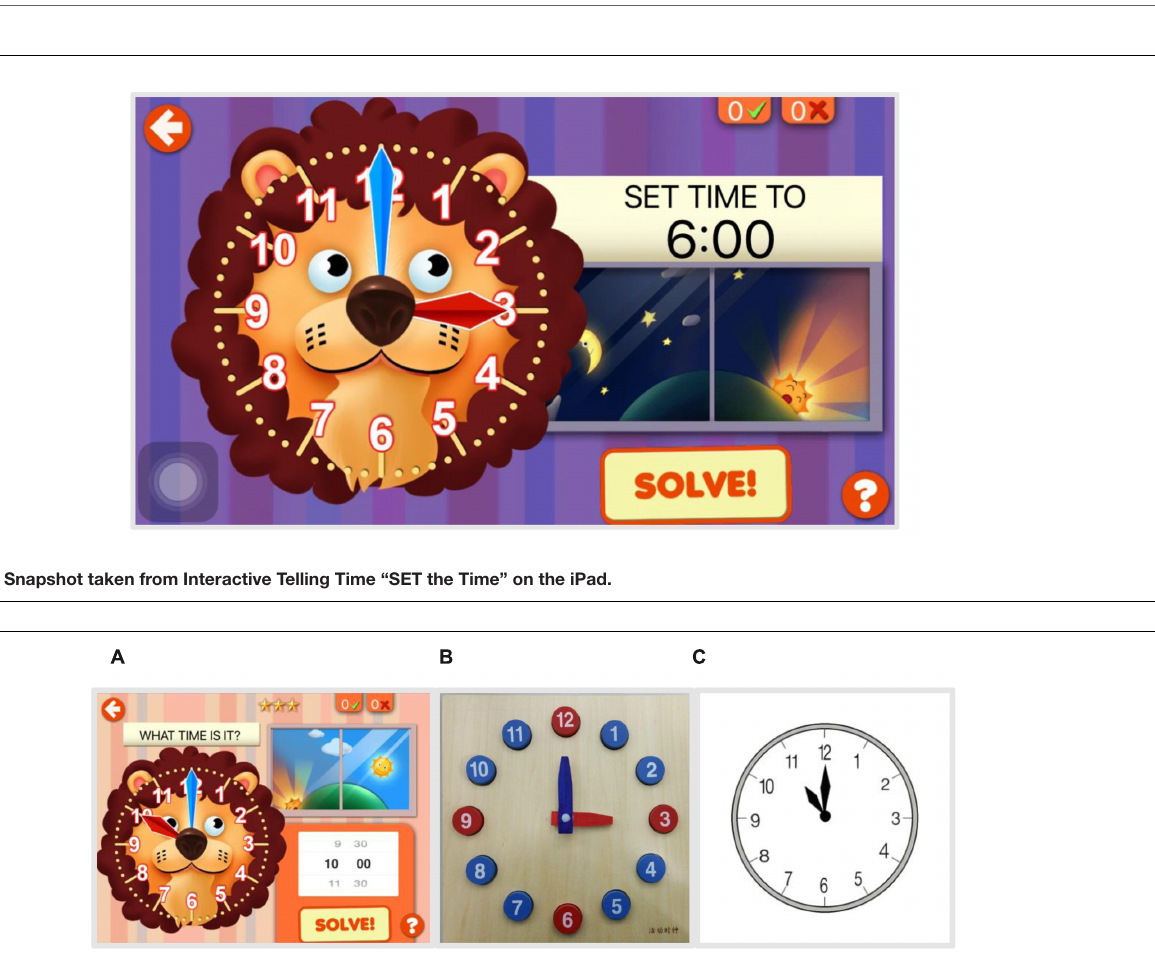
FIGURE 2 | The apparatuses were used in the post-test of three different groups. (A) Test module “What’s the time?” on the iPad touchscreen app used in the iPad test group. (B) A real toy clock used in the toy clock test group. (C) One of the test trials used in the paper test